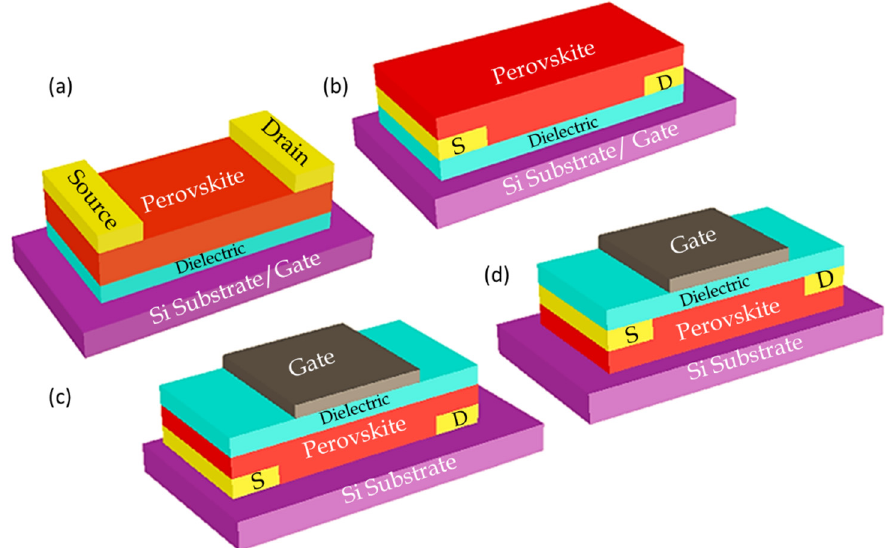
Figure 4. Device structures of perovskite FETs with four different globally recognized configurations ( a ) bottom gate top contact (BGTC), ( b ) bottom gate bottom contact (BGBC), ( c ) top gate bottom contact (TGBC) and ( d ) top gate top contact (TGTC).